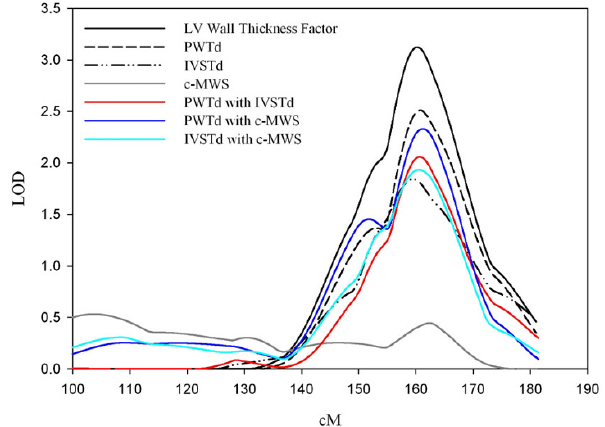
Figure 1 Multipoint linkage plots for LV wall thickness factor and univariate and bivariate linkage plots for its major component variables on chromosome 7 in whites . Logarithm of odds (LOD) scores (y-axis) and their respective cM (x-axis) from the p-telomere (left) to the q-tel- omere (right) are shown. PWTd = posterior wall thickness, IVSTd = interventricular septal thickness, c-MWS = stress- corrected midwall shortening.